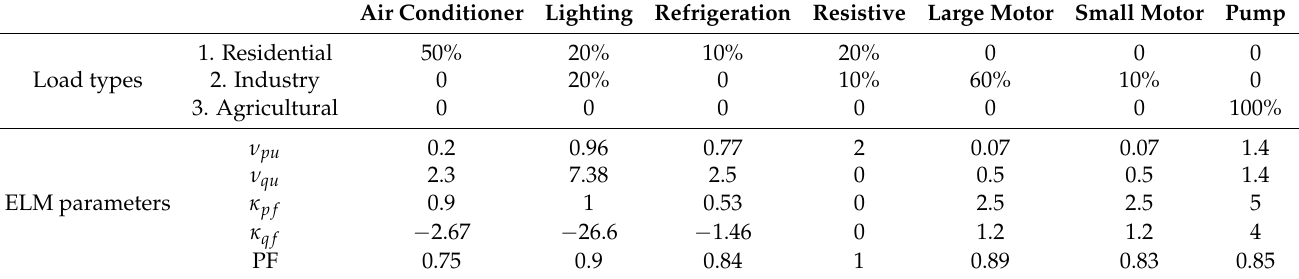
Table 3. Load characteristics.